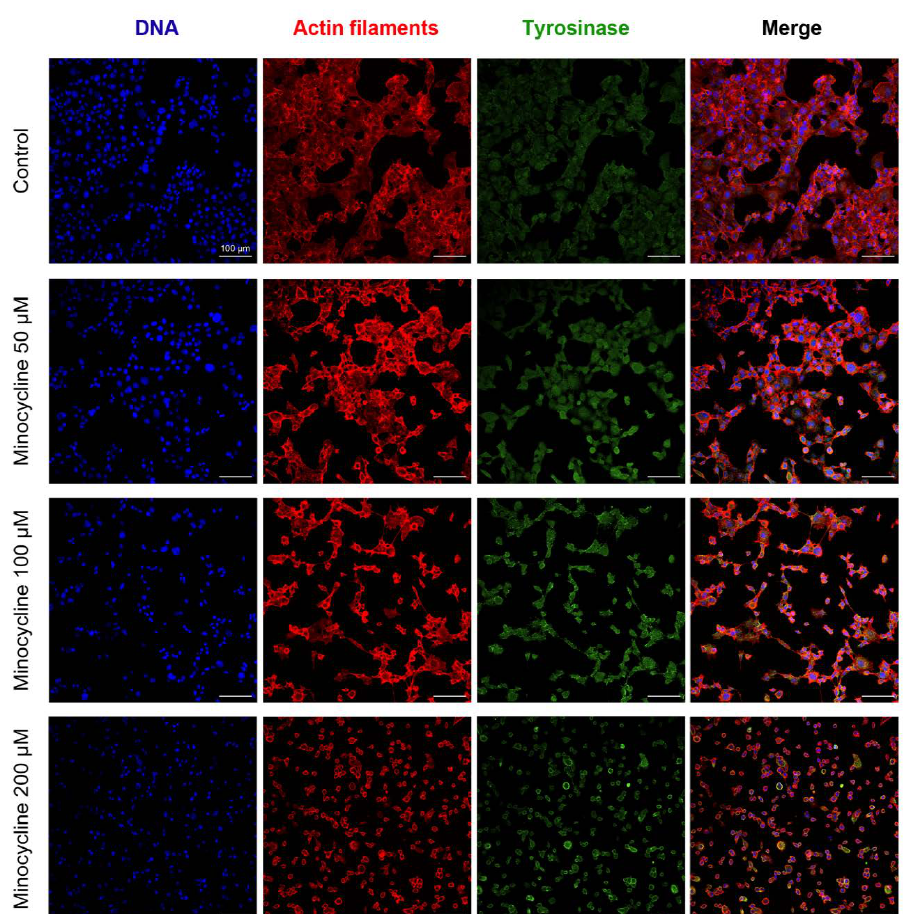
Figure 3. Confocal microscopy imaging of human melanoma cells treated with minocycline in concentrations of 50 µM, 100 µM, and 200 µM. Photographs are presented as separate channels for DNA, actin filaments, and tyrosinase as well as merge images. Scale bar 100 µm. 2.3. The Assessment of Human Melanocyte Viability after the Treatment with Minocycline